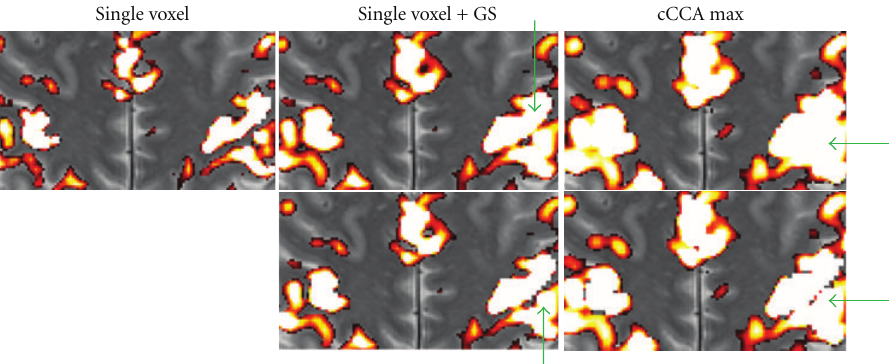
Figure 8: Magnified motor activation maps from Figure 6 for selected analysis methods (single voxel without Gaussian smoothing, single voxel with Gaussian smoothing (GS), and CCA with the maximum constraint (cCCA max)). The top row shows the original images at FWE < 0.05 without any correction for the smoothing artifact. The bottom row shows the original images corrected for the smoothing artifact. The green arrows point to major di ff erences of the activation patterns. Note that correction for the smoothing artifact leads to a splitting of activation pattern in the left (radiological convention) motor cortex (see bottom row images with green arrows pointing to the ROI).